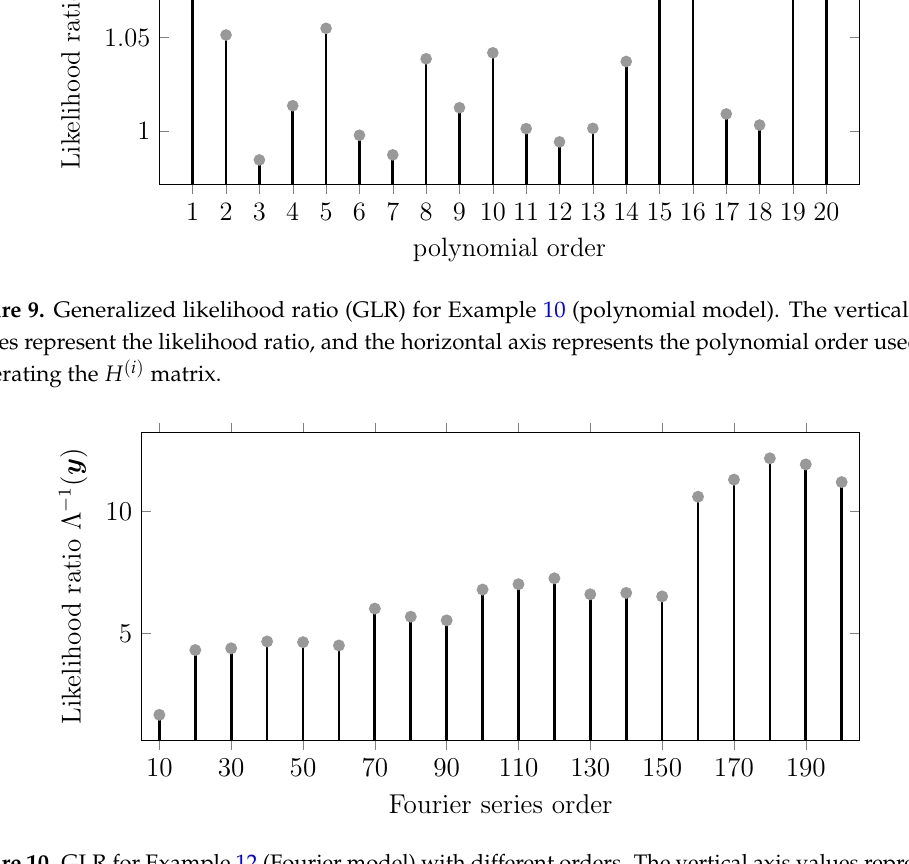
Figure 10. GLR for Example 12 (Fourier model) with different orders. The vertical axis values represent the likelihood ratio and the horizontal axis represents the Fourier series order used for generating the H ( i )